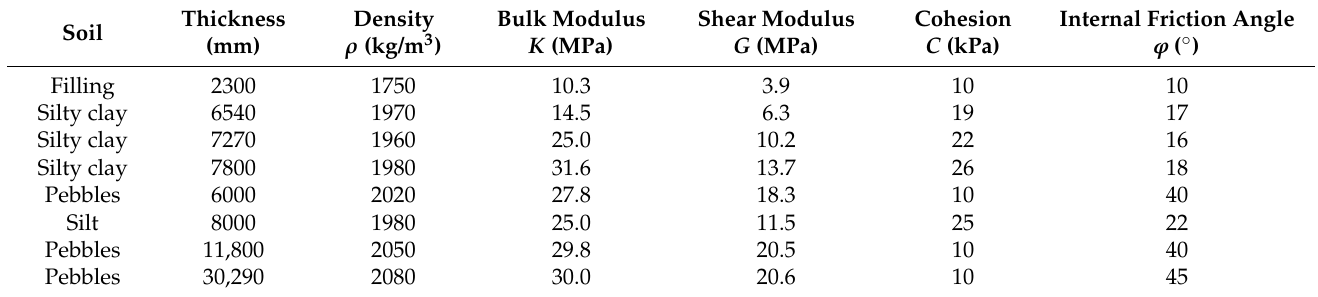
Table 1. Soil properties.